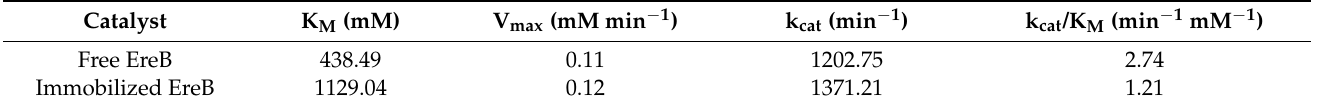
Table 1. Comparison of kinetic parameters of free and immobilized